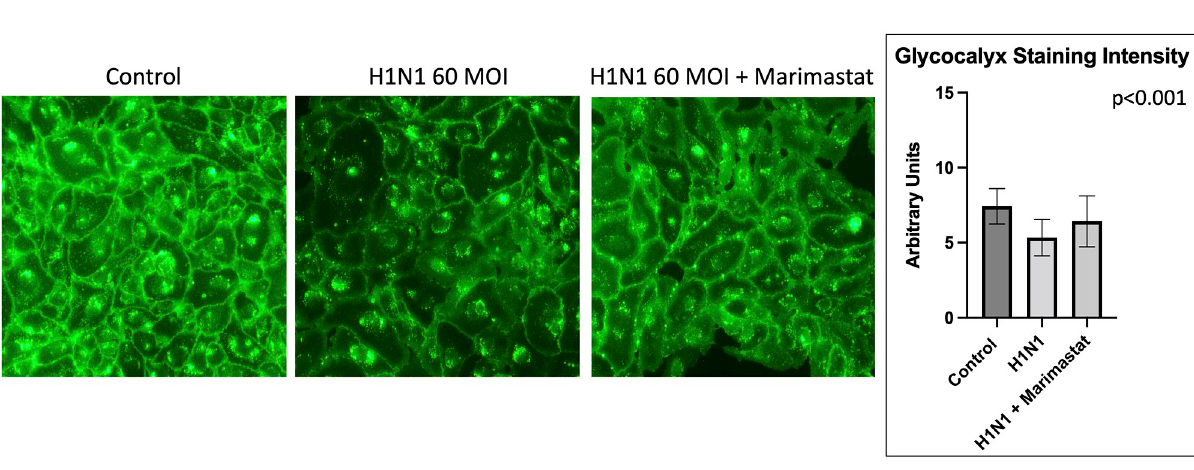
Fig 7. Metalloproteinase inhibitors protect the glycocalyx. Representative images and comparison of glycocalyx staining intensity shows that glycocalyx staining intensity is preserved when H1N1 infection occurs in the presence of the metalloproteinase inhibitor marimastat for human umbilical vein endothelial